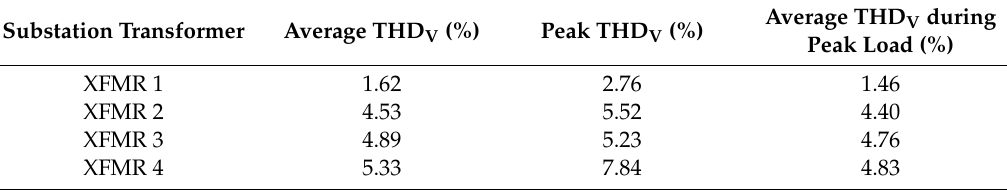
Table 1. Harmonic voltage monitoring results.